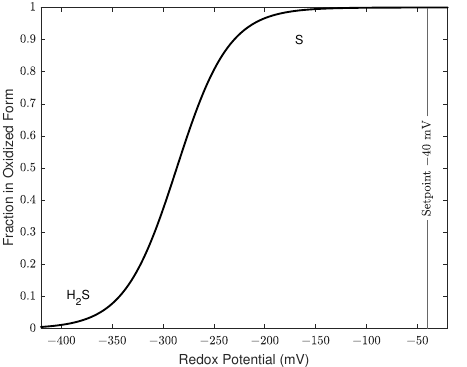
Figure 1. Fraction in oxidized form of S/H 2 S redox couple at 3.5 pH and standard conditions at the Ag/AgCl